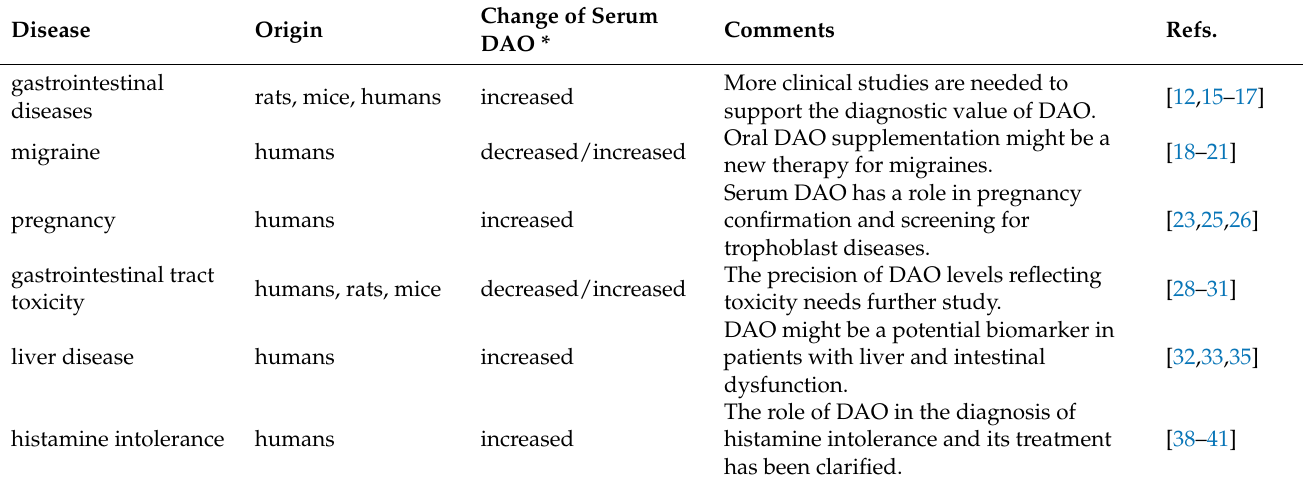
Table 1. Serum DAO in different